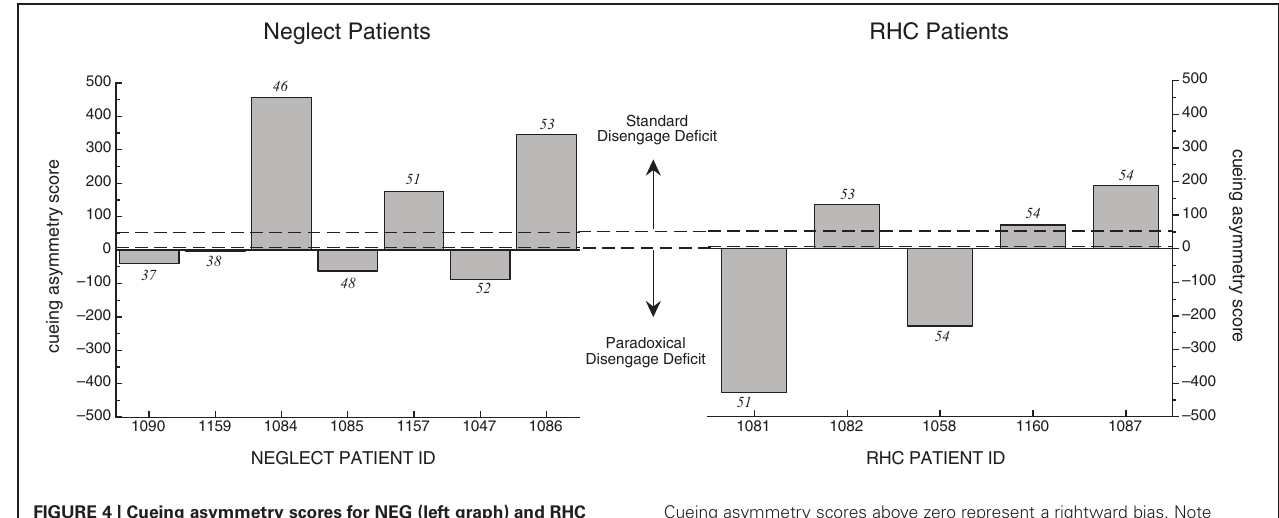
FIGURE 4 | Cueing asymmetry scores for NEG (left graph) and RHC group (right graph) in the RT task. Patients are represented in order of the BIT Star Cancellation scores, from lowest to highest (individual BIT Star Cancellation scores are listed above or below the individual bars).